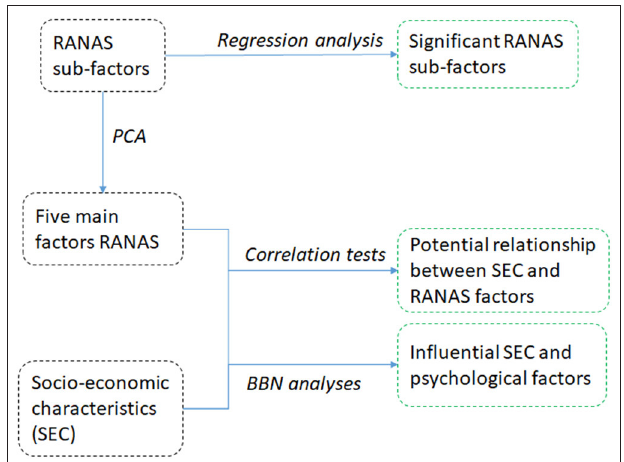
FIGURE 3 | Summary of the